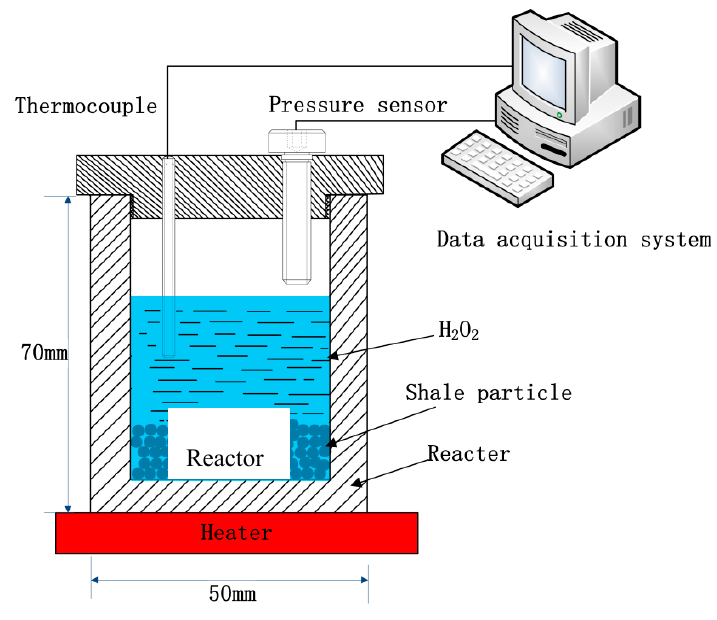
Figure 2. Experimental set up.